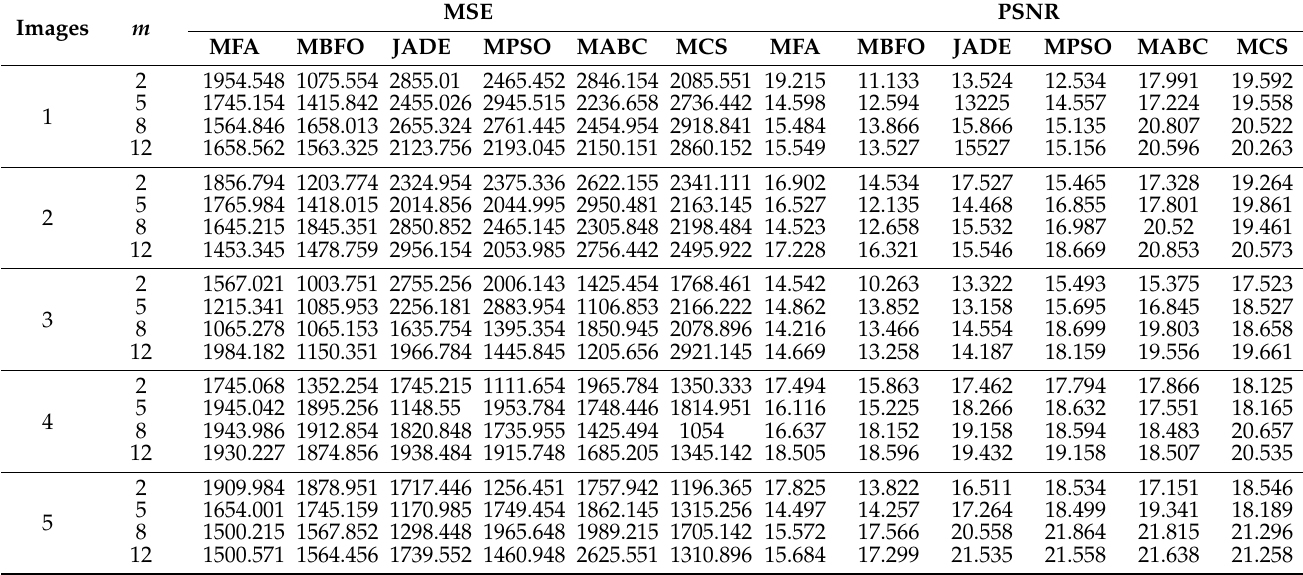
Table A2. MSE and PSNR values computed using different optimization algorithms with the EC-Otsu method. Images